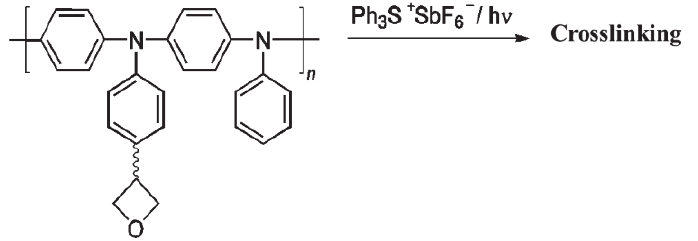
Figure 25. The cationic crosslinking of a hole defect polyarylamine.